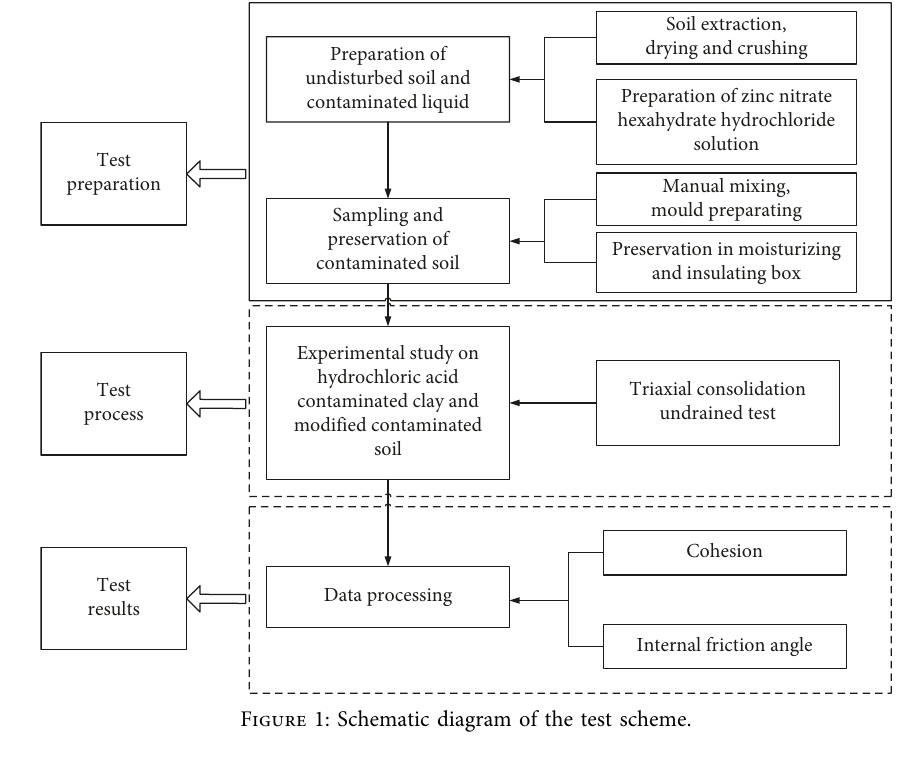
Figure 1: Schematic diagram of the test scheme.